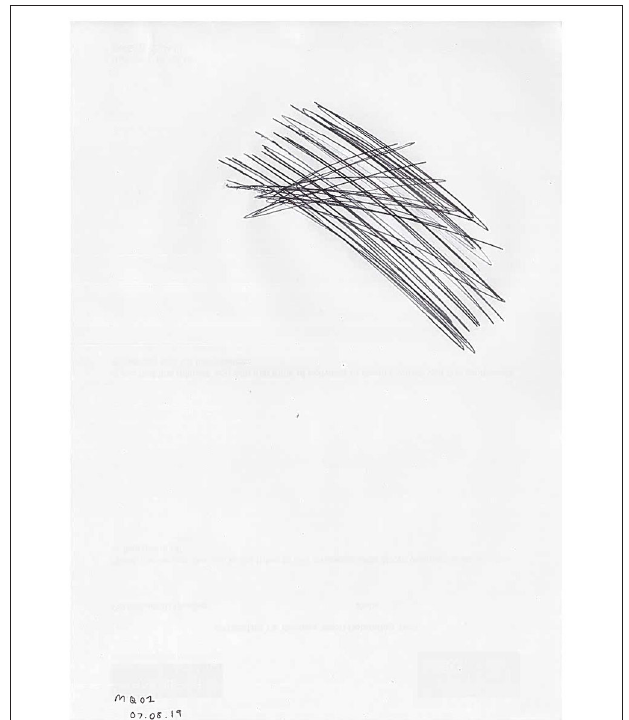
FIGURE 2 | MQ01 drawing of emotions experienced before suicide